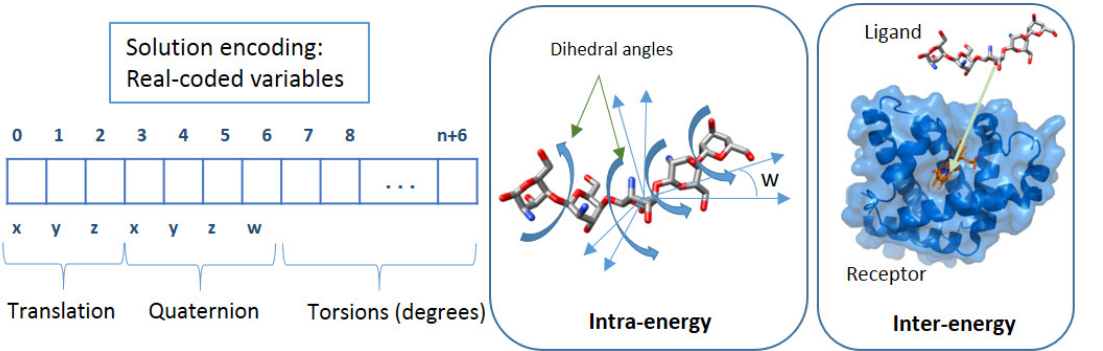
Figure 1. Solution encoding in AutoDock 4.2 and jMetal. The first three values (translation) are the coordinates of the center of rotation of the ligand. The next four values (quaternion) are the unit vector describing the direction of rigid body rotation ( x , y and z ) and the rotation of the angle degrees ( w ) that are applied. The rest of the values holds the torsion angles in degrees, n being the number of torsions of the ligand and also the receptor. Movements concerning the E and E calculation are also inter intra